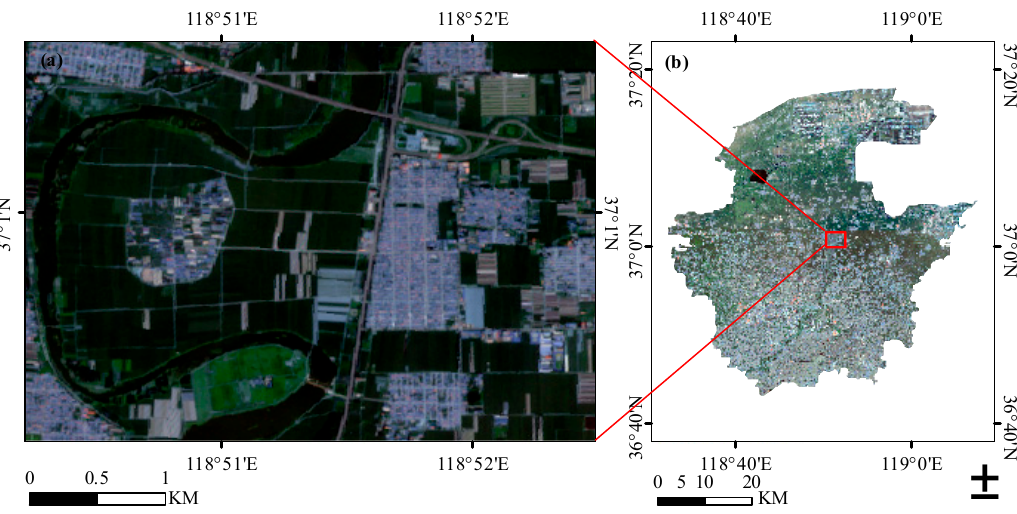
Figure 1. The studied area with Sentinel-2 composite. ( a ) Sentinel-2 composite (bands 4, 3, and 2 assigned to the red, green and blue) in the study area with a 10-meter resolution; ( b ) Sentinel-2 composite (bands 4, 3, and 2 assigned to the red, green, and blue) in Shouguang City.